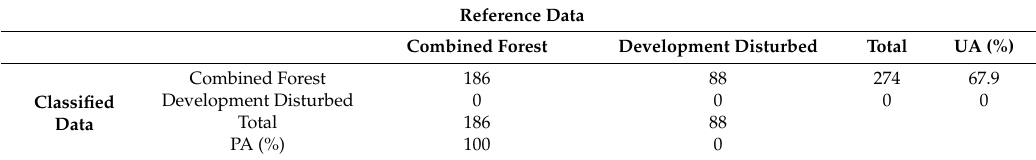
Table 3. Error matrix from NLCD Change Product map.